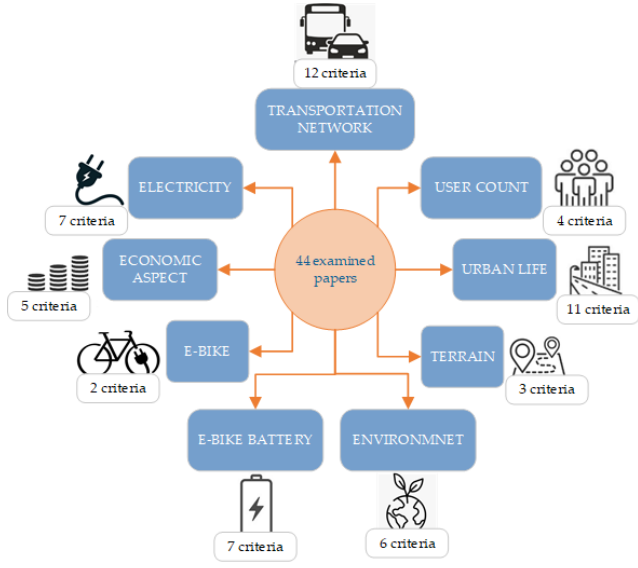
Figure 1. Criteria set at the main level.